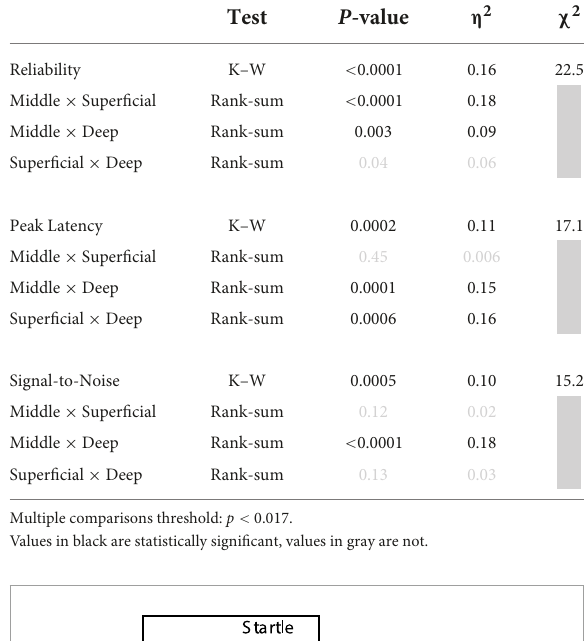
TABLE 2 Variability of reliability, peak latency, and signal-to-noise by depth.